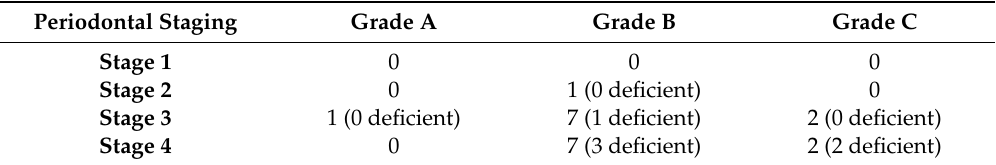
Table 2. Patient periodontal characteristics.